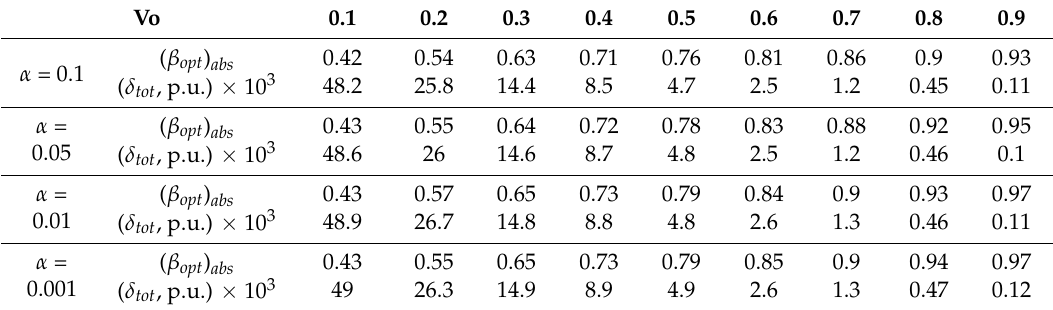
Table 1. Optimal values of the coefficient β .